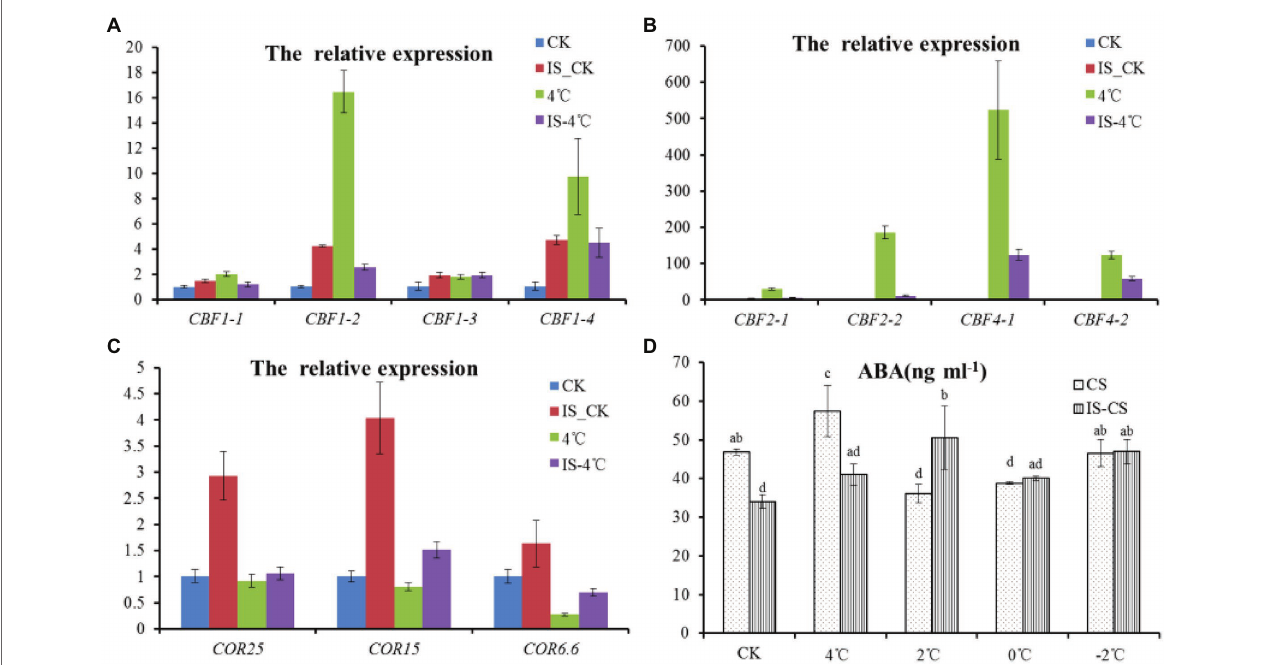
FIGURE 3 | Expression patterns of CBFs , CORs , and ABA content with exogenous inositol under cold stress. (A) The expression patterns of CBF1 ( CBF1-1- CBF1-4 ) with exogenous inositol under cold stress; (B) The expression patterns of CBF2 ( CBF2-1 and CBF2-2 ) and CBF4 ( CBF4-1 and CBF4-2 ) with exogenous inositol under cold stress; (C) The expression patterns of CORs ( COR25 , COR15 , and COR6.6 ) with exogenous inositol under cold stress; (D) ABA content change with exogenous inositol under cold stress. CK: 22 ° C; 4 ° C: 4 ° C treatment for 1 h; IS_CK: 22 ° C for 1 h with 0.5 g L − 1 of exogenous inositol; IS_4 ° C: 4 ° C for 1 h with 0.5 g L − 1 of exogenous inositol.